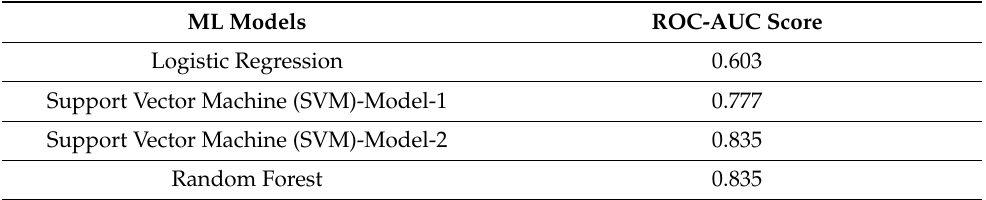
Table 5. ROC-AUC values for Logistic regression, SVM and Random Forest